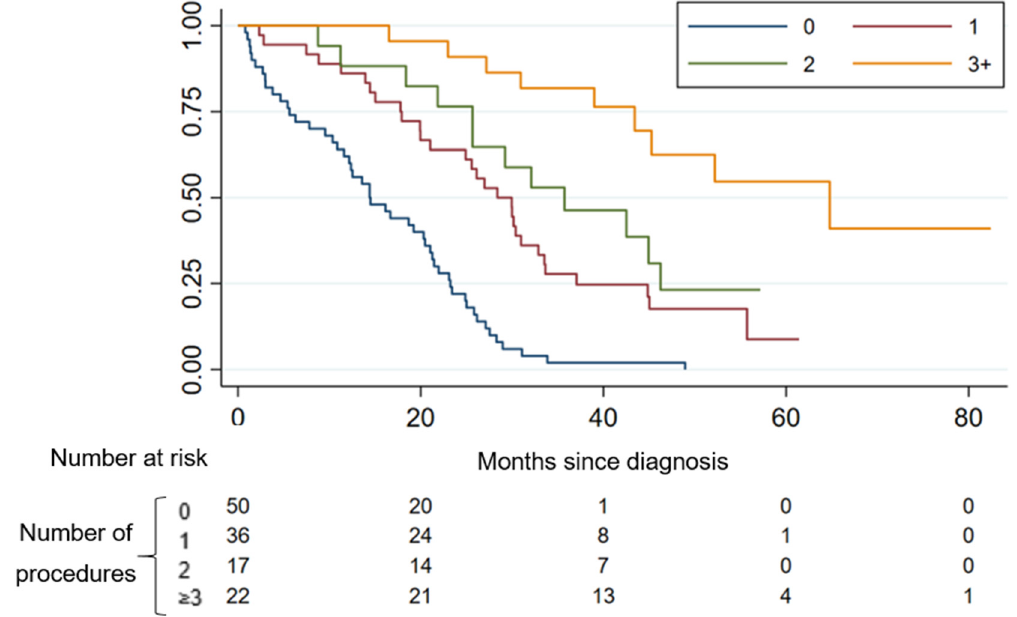
Figure 2. Overall survival by increasing number of multimodal procedures.